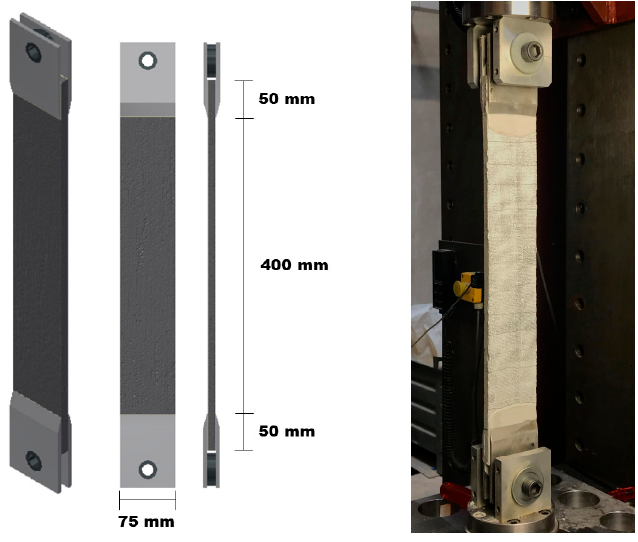
Figure 5. Uniaxial test set-up and dimensions.